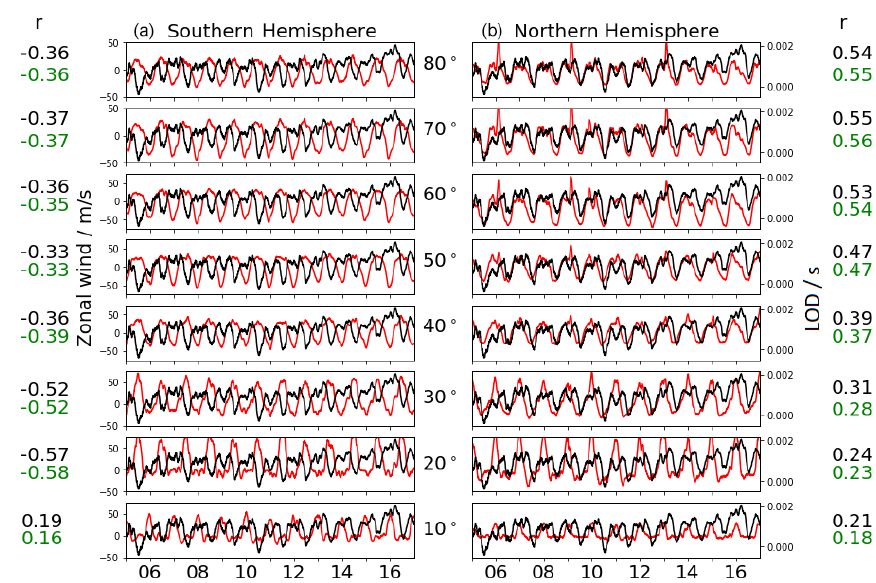
Figure 8. Zonal MLS wind (red) and LOD (black) at ∼ 80km geometric height for 0–20 ◦ E. The left part shows the values for the Southern Hemisphere and the right for the Northern Hemisphere for every 10 ◦ latitude. The black correlation coefficients ( r ) are estimated for the mean between 0 and 20 ◦ E, and the green coefficients correspond to the global average over all longitudes. Table 1. Correlation coefficients between the zonal wind and the LOD. Positive values corresponds to the occurrence of an eastward-directed mean zonal wind together with a positive fluctuation in the